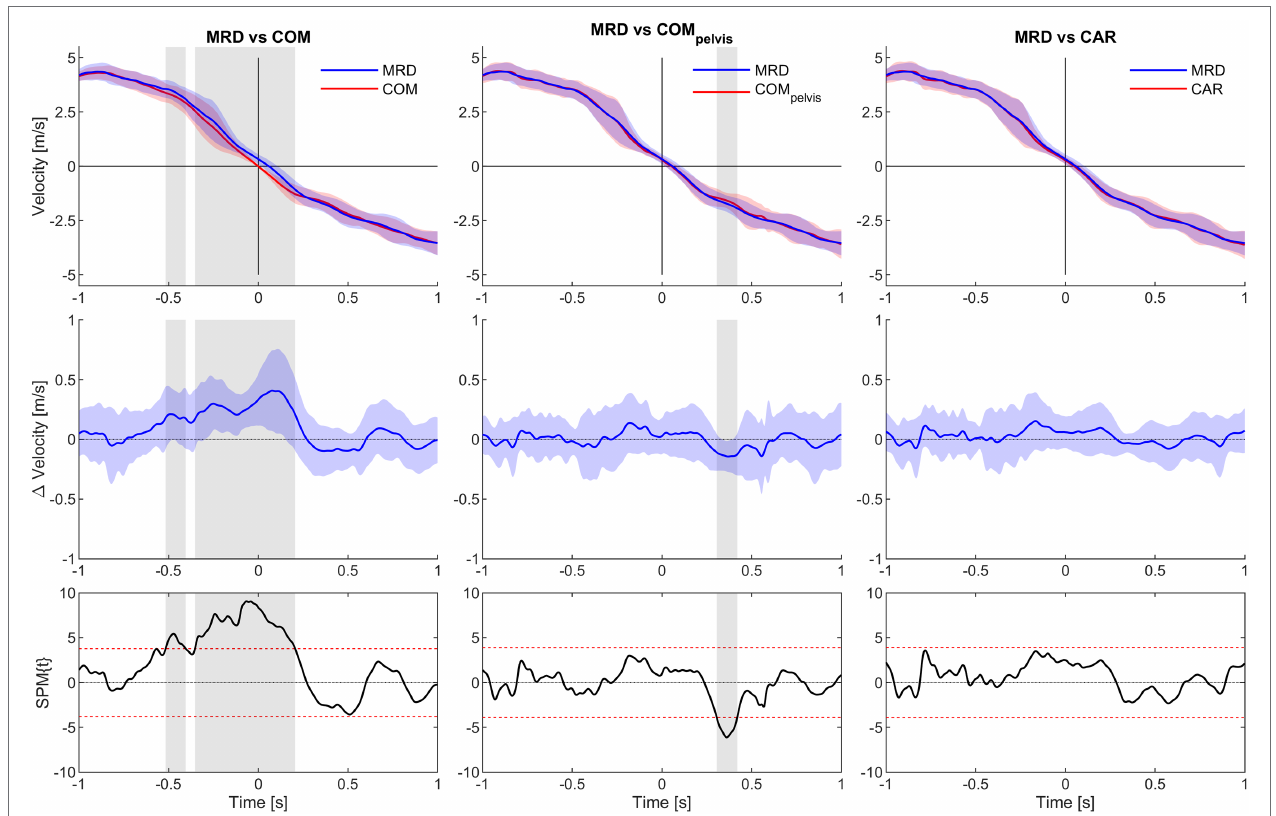
FIGURE 7 | SPM analysis of average velocity for 1.0 s time interval before ( − ) and after (+) CoD (horizontal axis all graphs) for the 9 kg condition. Columns left to right show MRD to COM, MRD to COM pelvis and MRD to CAR comparisons. Top row show average velocity of all trials with 95% confidence interval for the MRD (blue) to COM, COM pelvis and CAR (red) comparisons. Middle row show difference in velocity with 95% confidence interval. Bottom row show SPM analysis with 95% confidence interval marked with red dashed lines. Grey vertical line identify time interval of significant difference ( α <